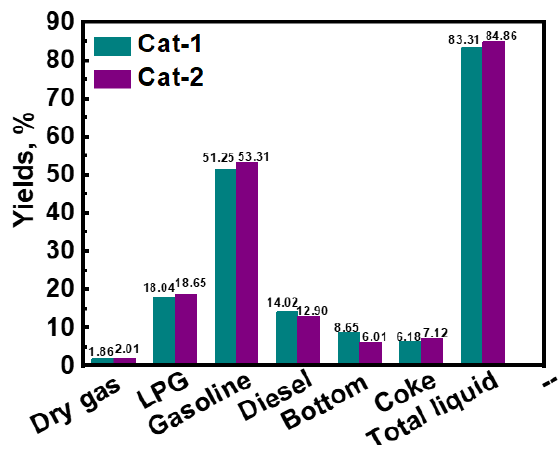
Figure 8. Heavy oil catalytic cracking performances of fresh FCC catalysts.